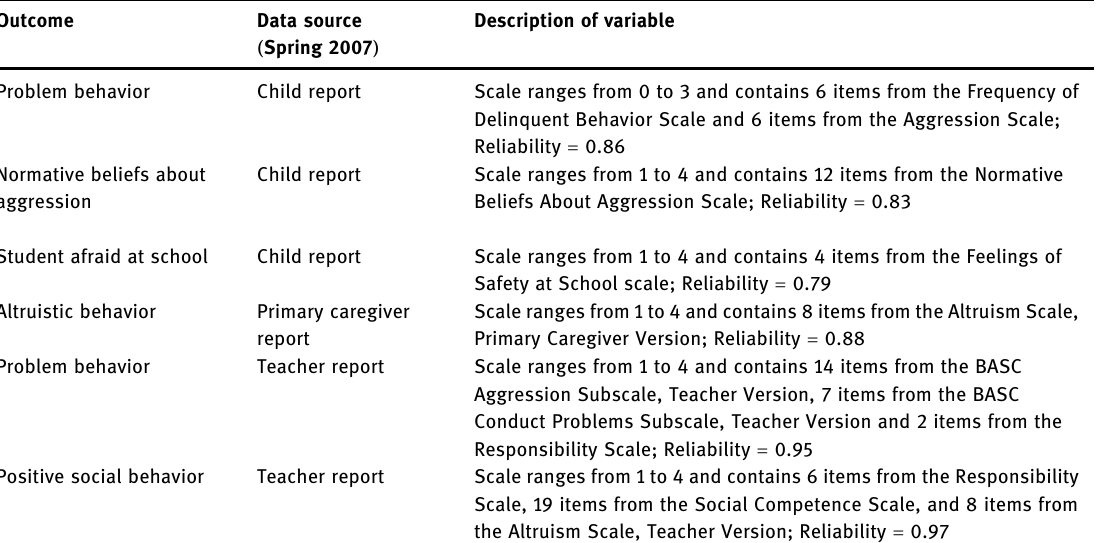
Table 2: Outcome variables for the empirical analysis using SACD RCT data Outcome Data source Description of ( Spring 2007 )